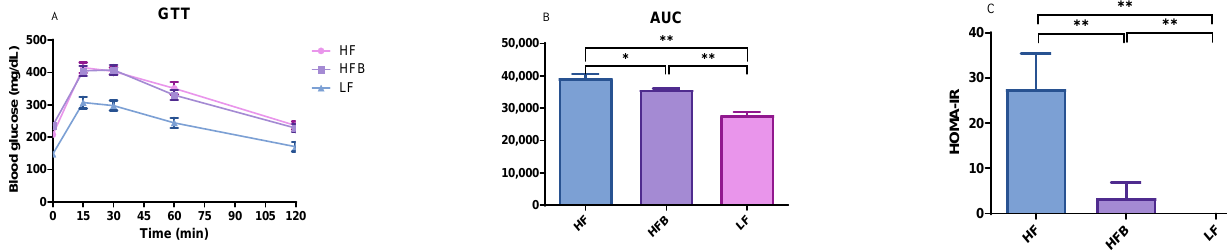
Figure 2. ( A ): Glucose tolerance test in mice fed high-fat (HF) diet, high-fat diet containing 20% cooked black turtle bean (HFB) and low-fat (LF) diet for 6 weeks; ( B ): Area under GTT curve after normalization; ( C ): HOMA-IR index of mice fed HF and HFB diets. * p < 0.05, ** p < 0.01 between groups. AUC: area under curve; GTT: glucose tolerance test; HOMA-IR: Homeostatic Model Assessment of Insulin Resistance (HOMA-IR) Index.